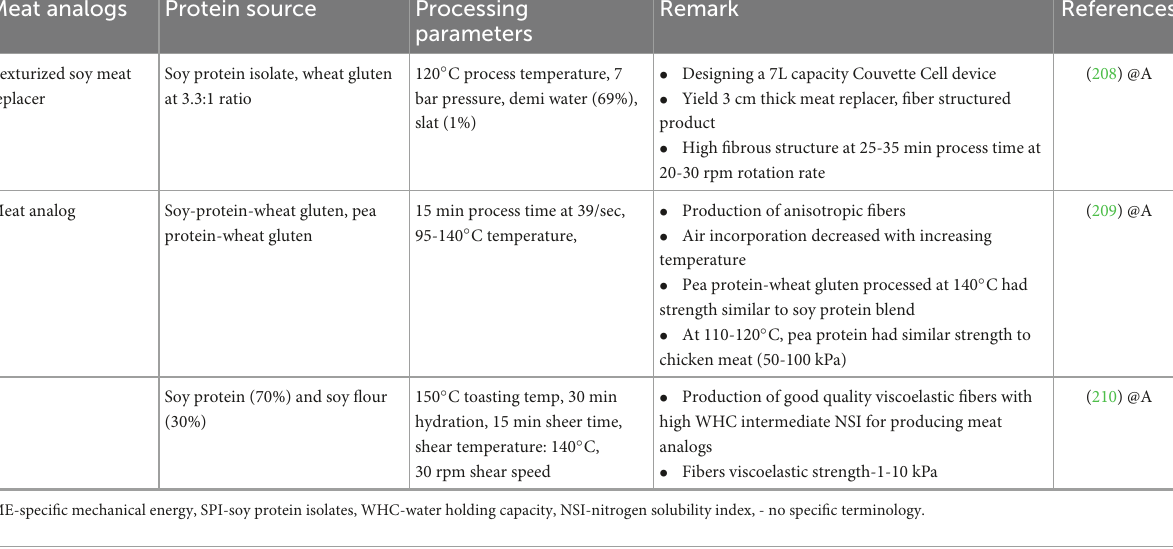
or concentric cylinder shear cells are used to texturize vegetable proteins by shear bindings, formation of layered structures, and their orientation toward shear flow under the effect of shear-induced concentration fluctuations.